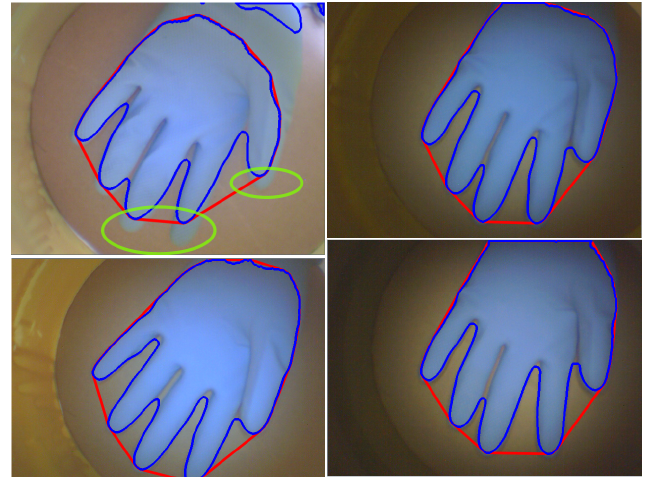
Fig. 9: Contours found in different light exposures. The paint- ing on the bottle effectively blocks out most of the external lights.